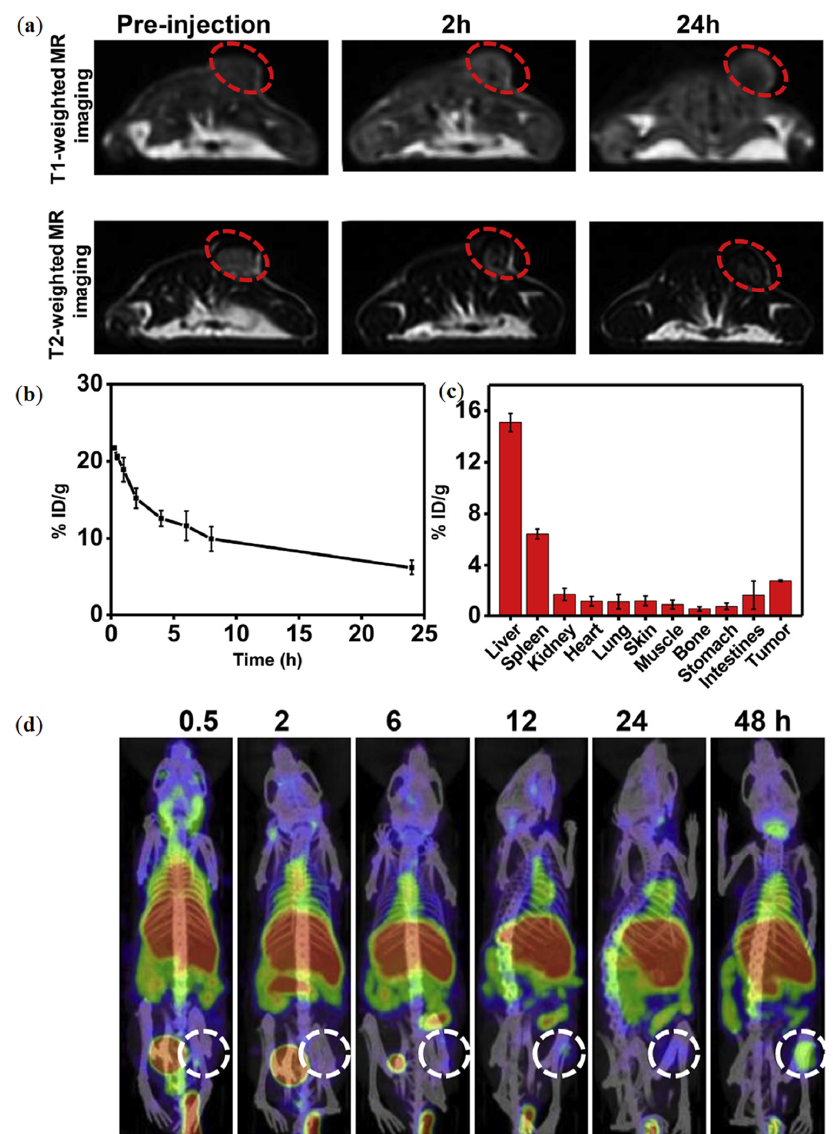
Figure 3. ( a ) MR imaging of mice treated with RGO-MnFe 2 O 4 -PEG nanocomposites; ( b , c ) in vivo performance of RGO-MnFe 2 O 4 -PEG nanocomposites. ( b ) The blood circulation and, ( c ) biodistri- bution of 125 I-RGO-MnFe 2 O 4 -PEG nanocomposites. ( d ) SPECT/CT imaging of mice treated with 125 I-RGO-MnFe 2 O 4 -PEG nanocomposites. Reprinted with permission from ref. [39]. Copyright 2019